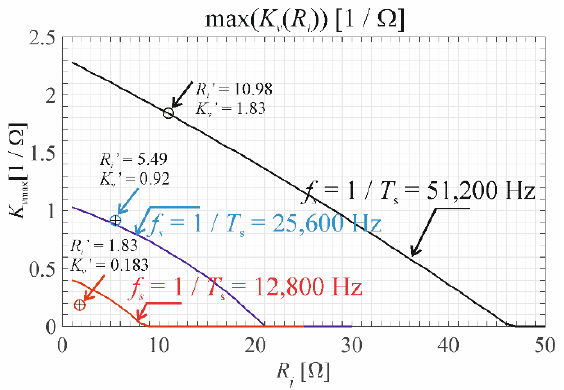
Figure 15. The recalculated values of the border gains R i ’, K v ’ for the experimental model vs. the theoretically appointed border curves.